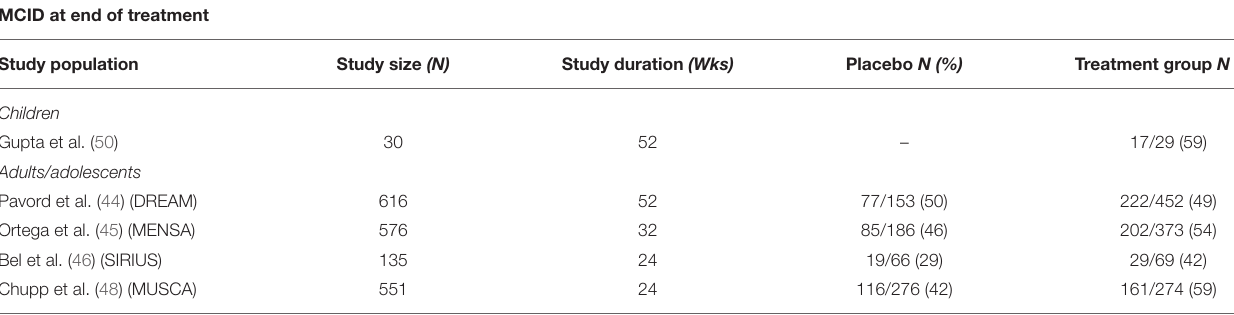
TABLE 1 | Minimally clinically important difference (MCID) in children and adults/adolescents at end of treatment. MCID at end of